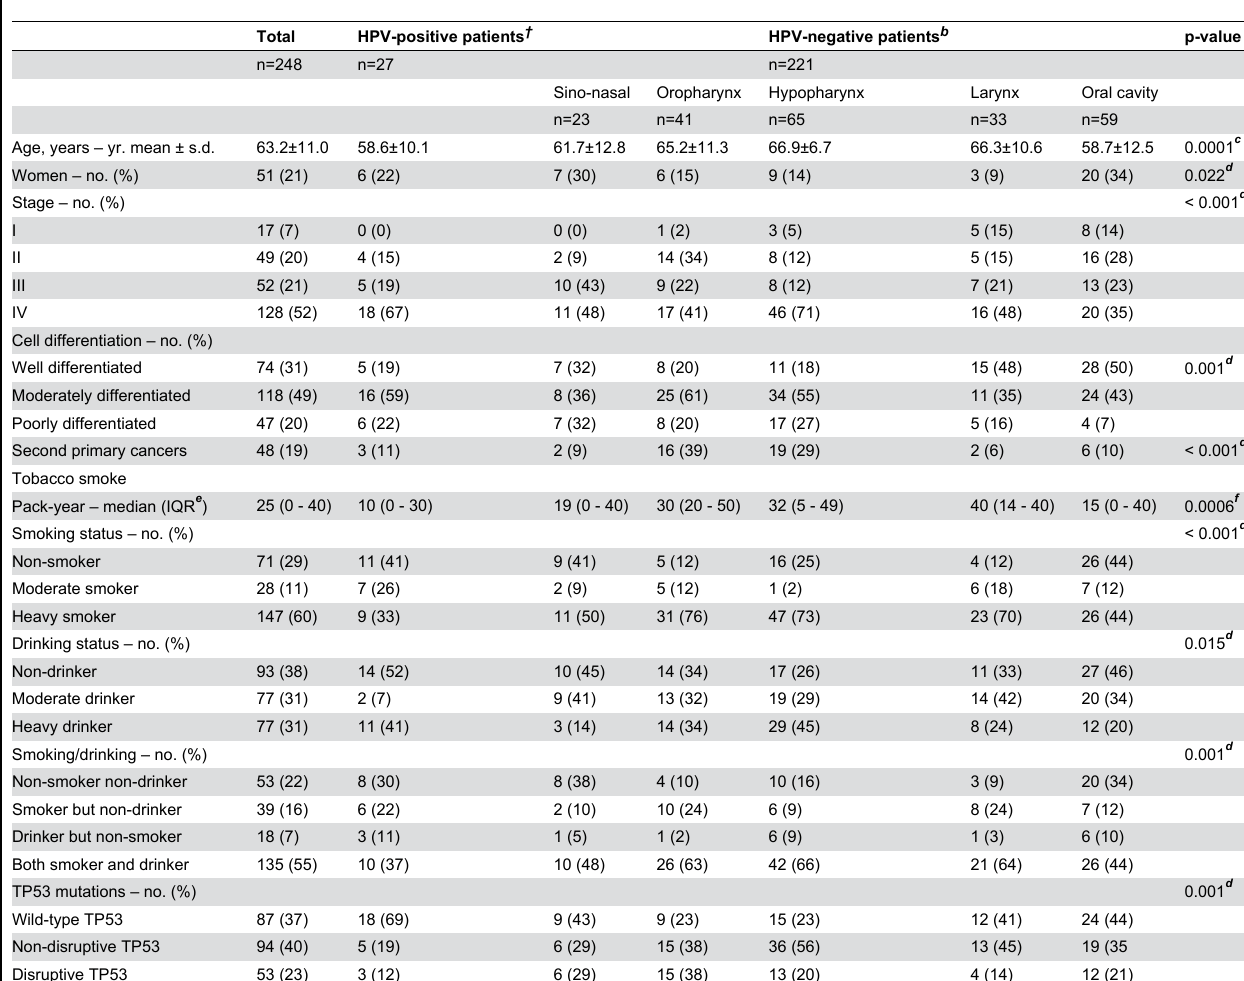
Table 1. Patient characteristics stratified by HPV positivity and primary tumor sites a .